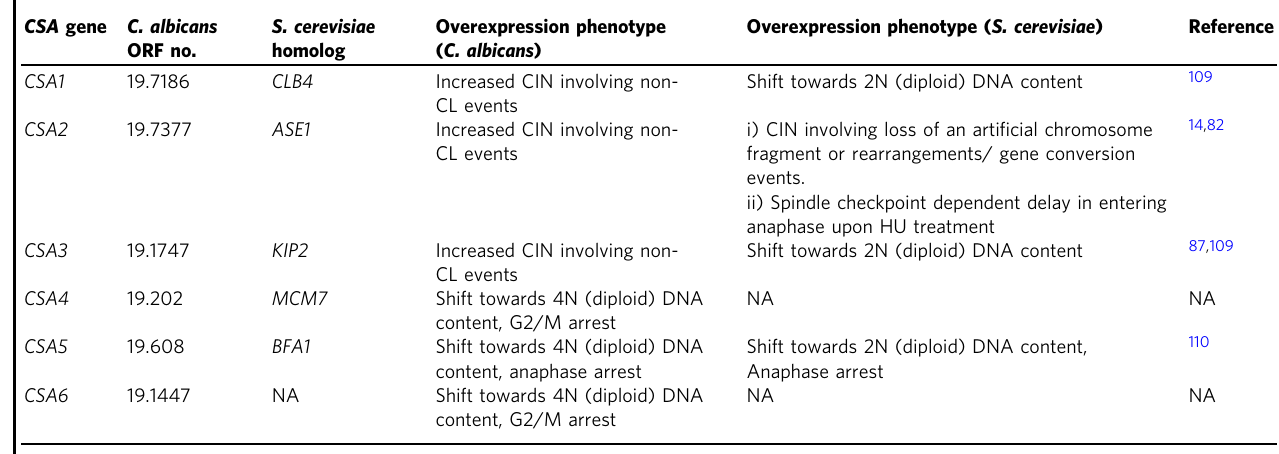
Table 1 Overexpression phenotypes of CSA genes in C. albicans and S. cerevisiae . CSA gene C. albicans ORF